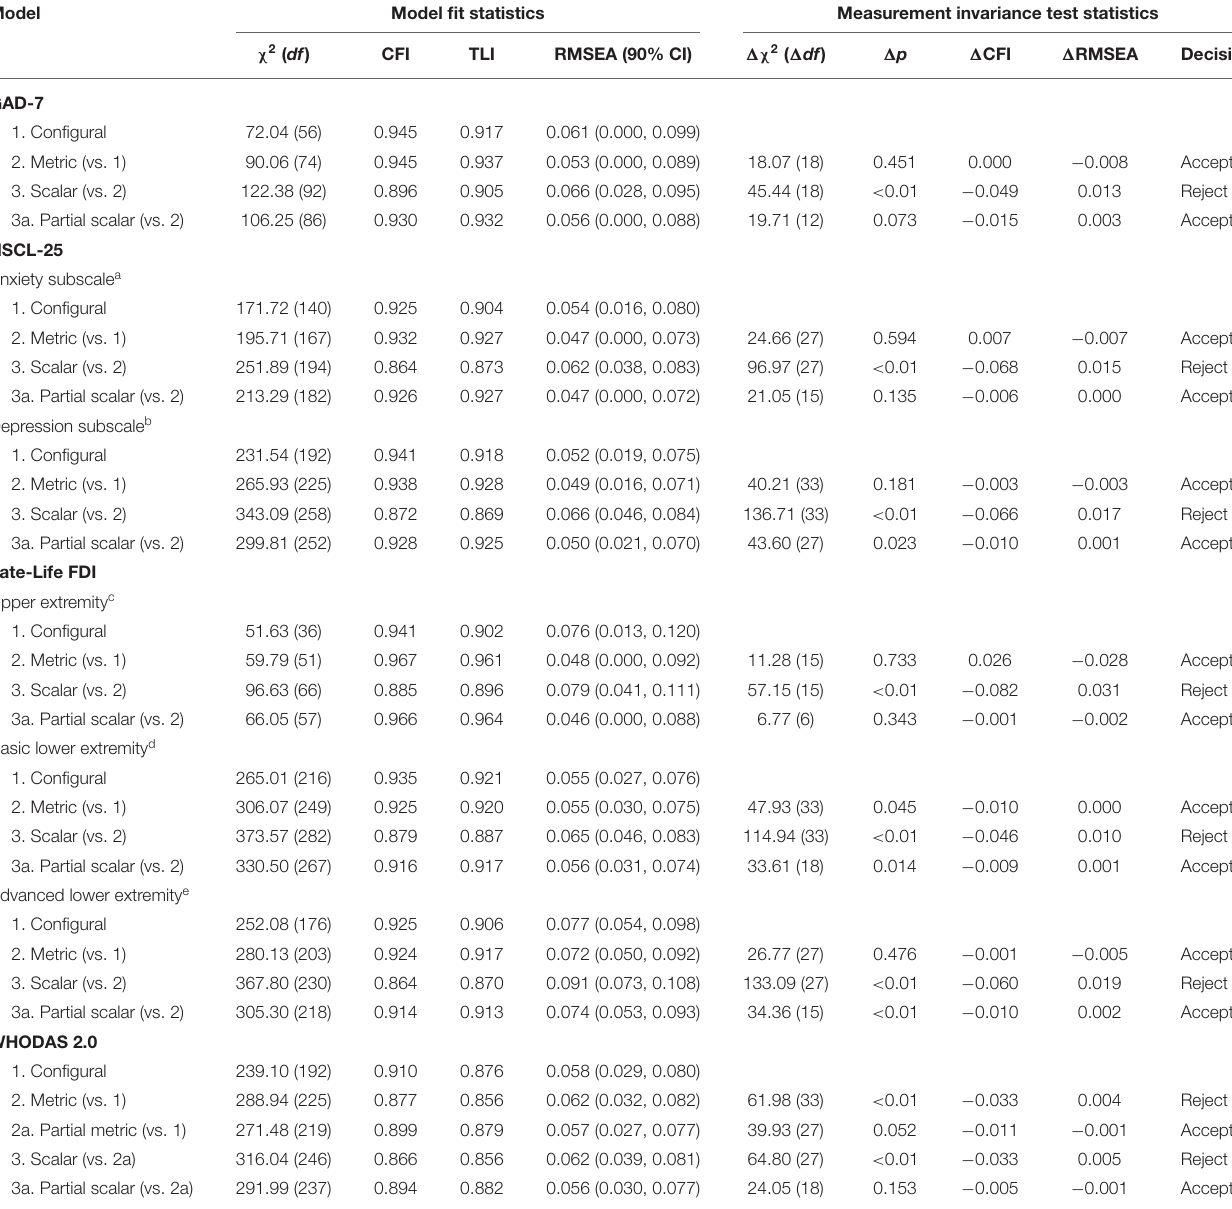
TABLE 2 | Measurement invariance testing of PMSB outcome measures across four language